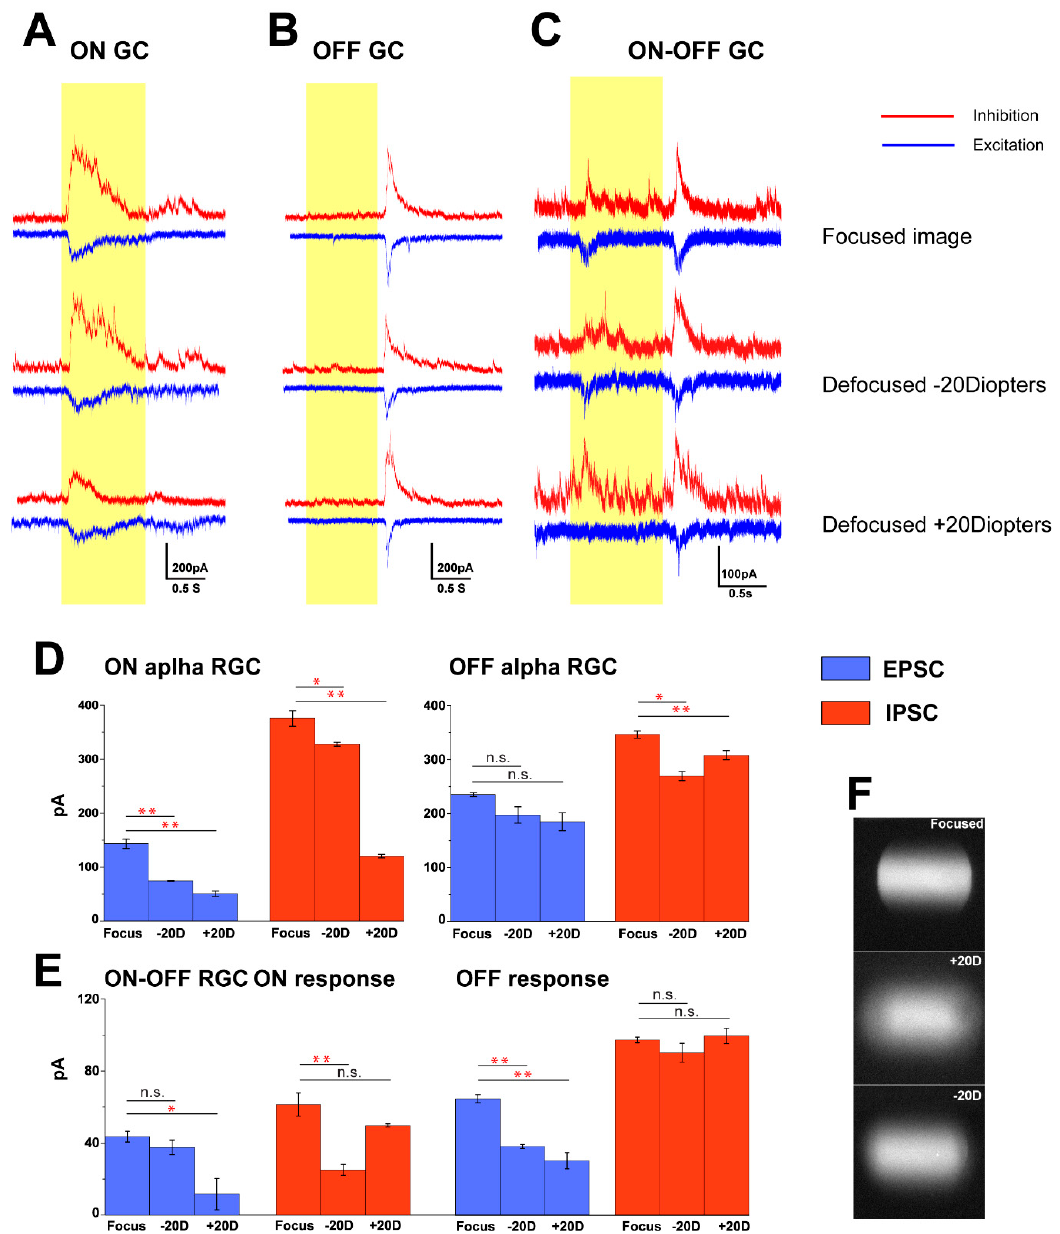
Figure 5. ON alpha, OFF alpha and ON–OFF RGCs had varied cell responses to focused and defocused images ( F ). ON alpha, OFF alpha and ON–OFF RGCs were identified based on their response profiles to lights ON and OFF. Inhibitory (red) and excitatory (blue) currents measured in voltage-clamped ON alpha GC, OFF alpha GC and ON–OFF GC ( A–C ) holding potential − 68mV and 0 mV in response to focused and equal to different dioptric powers of optical defocus ± 20D as indicated. Light stimuli of 1 s, 0.002 cycles/degree light stimuli (light intensity = 5.09 × 10 4 Rh*/rod/sec) was projected on the outer segment of the photoreceptor layer. Defocused images had significantly different effects on EPSCs and IPSCs responses in these cells ( D , E ). ∗∗ p < 0.01; ∗ 0.01 < p < 0.05; n.s. p > 0.05.